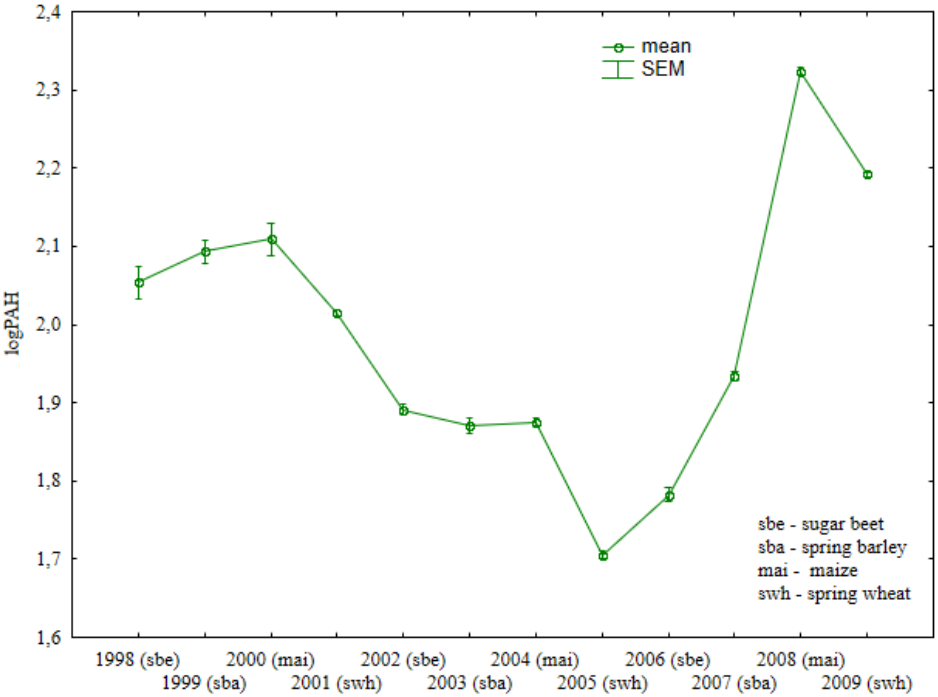
Figure 3. Total content of heavy PAHs in soil under different crops (log transformed data for 1998– 2009).